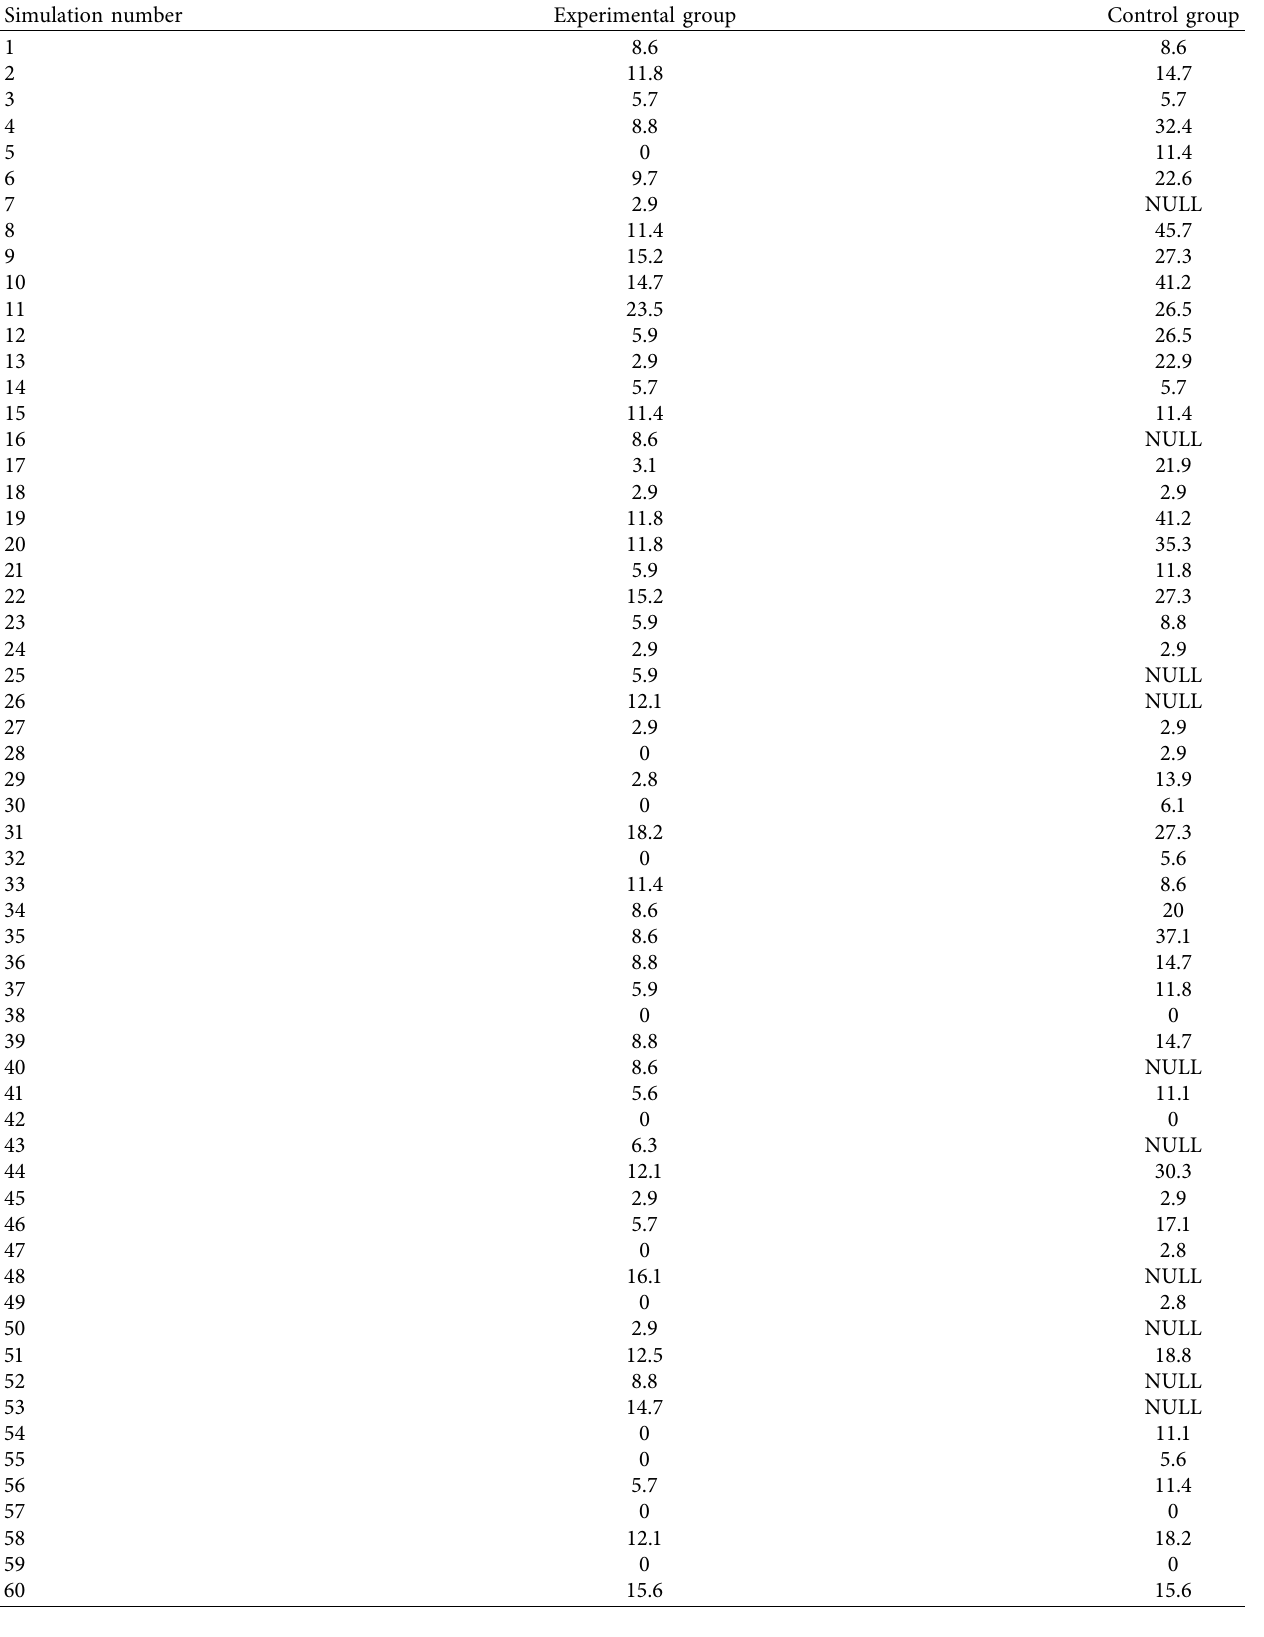
Table 3: The single-robot repetition rates (%) of different execution methods in 100